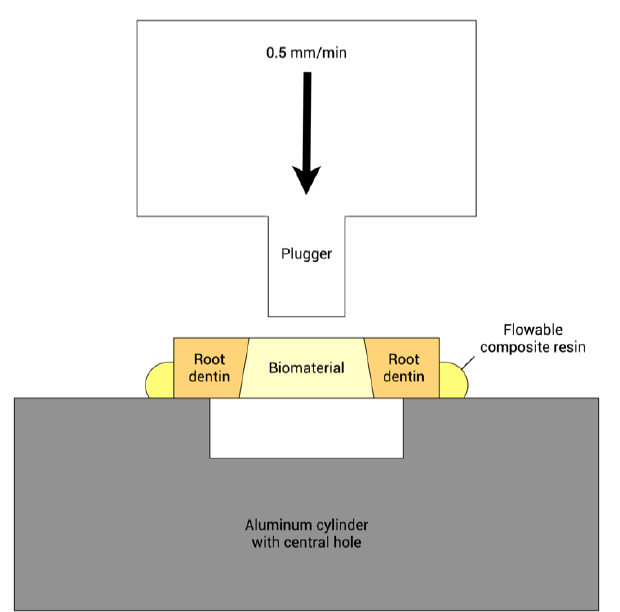
Figure 2. Schematic representation of the push-out bond strength test set-up ( arrow : compressive load direction).